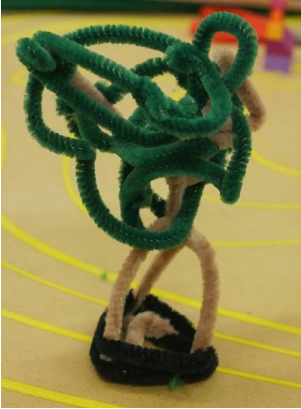
Figure 2. The authentic tree (source: created by